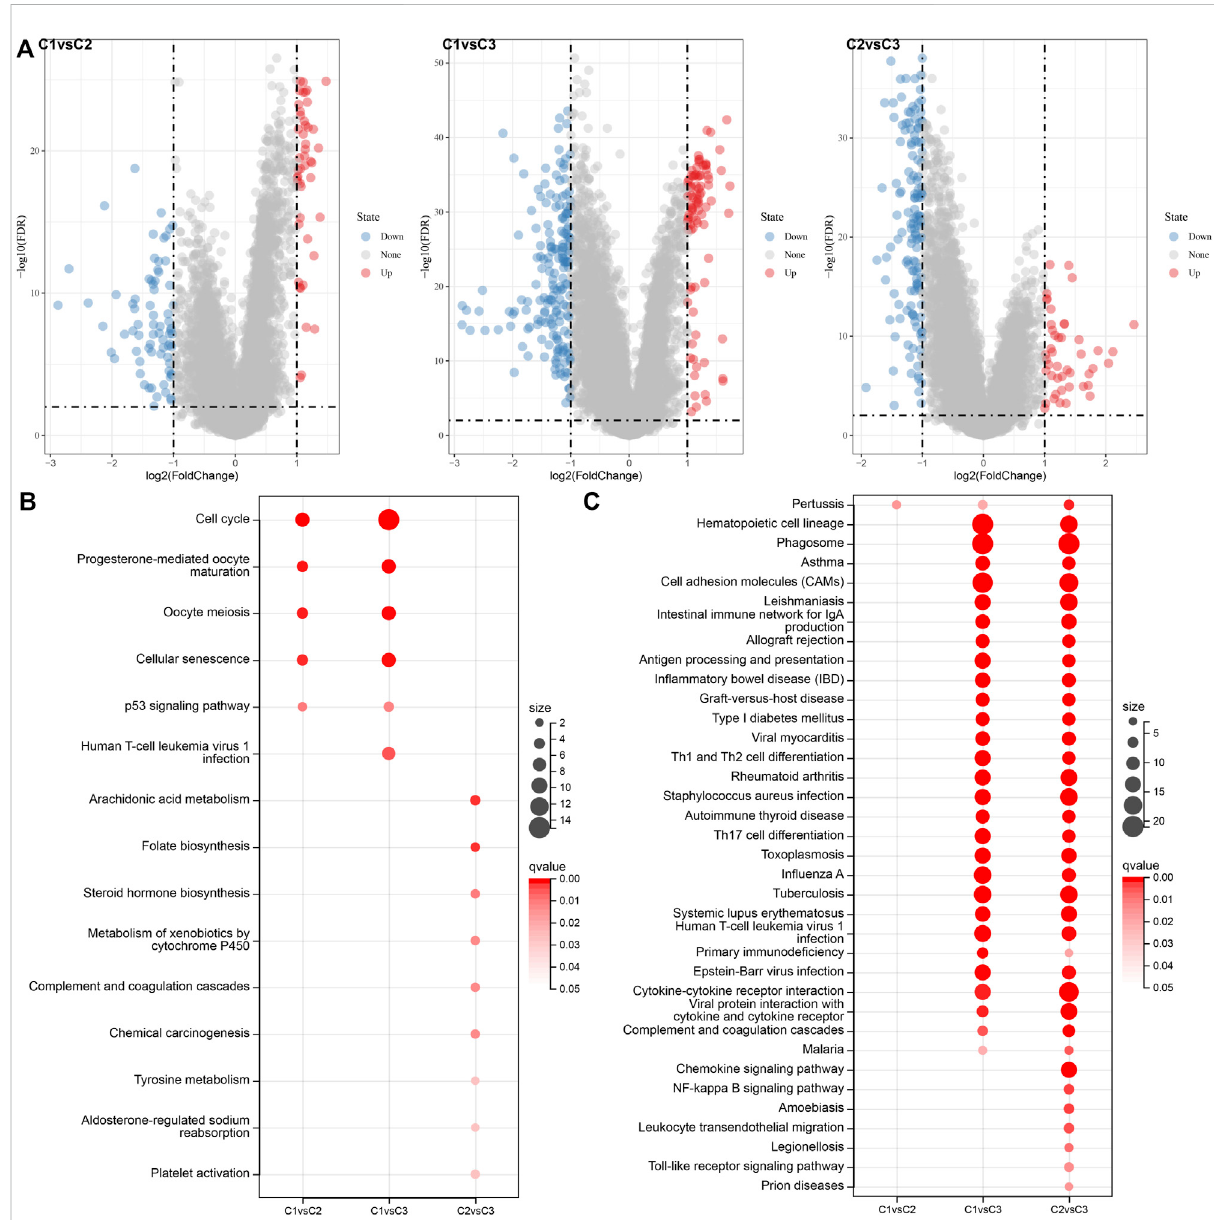
Differential expression analysis between molecular subtypes. (A) Volcano diagram of DEGs among TCGA molecular subtypes; (B) Bubble chart of KEGG function enrichment analysis results of differentially up-regulated genes among TCGA molecular subtypes; (C) Bubble chart of KEGG function enrichment analysis results of differentially downregulated genes among TCGA molecular